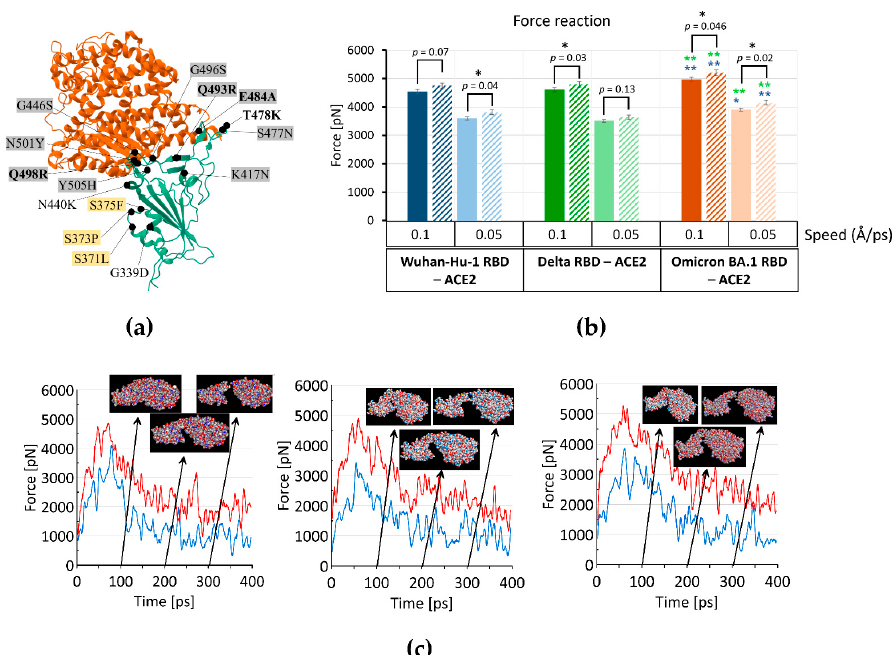
Figure 1. ( a ) Cryo-EM structure of SARS-CoV-2 Spike Omicron BA.1 RBD (cyan) with ACE2 domain (orange) (https://www.rcsb.org/3d-view/7T9L/1, assessed on 1 June 2022). Positions mutated in Omicron BA.1 are shown as black circles. Grey boxes indicate mutations that are at the binding interface with ACE2, N440K, and T478K are just peripheral and might influence the binding, and yellow boxes indicate mutations that affect the lipid-binding pocket of Spike RBD [45,64,67,68]. Bold—mutations within RBM at the binding interphase with ACE2 or adjacent to it that increase the positive charge (T478K, Q493R, Q498R) or decrease the negative charge (E484A) according to [56,57]. ( b ) The force reaction in steered Molecular Dynamics simulations of separating the RBD domain from the ACE2 with constant speed 0.1 or 0.05 Å/ps (indicated below the x-bar) of different SARS-CoV-2 variants: Wuhan-Hu-1 (6m0j, dark and light blue), Omicron BA.1 (7t9l, dark and light red), Delta (7w9i, dark and light green), and each protonated form (diagonal line pattern). The mean of eight independent experiments is shown in each case, and the standard error of the mean is shown as error bars. The t -test was used for comparing the means, and p -levels are indicated above the bars; *—denotes a significant difference at the p -level < 0.05, **—denotes significant difference at the p -level < 0.01. Blue and green asterisks above the Omicron BA.1 bars correspond to significant differences between the corresponding bars of Omicron BA.1 RBD and Wuhan-Hu-1 RBD (blue) and Omicron BA.1 RBD and Delta RBD (green). ( c ) Timeline (Force pN/Time ps) of pulling the RBD of Wuhan-Hu-1, Omicron BA.1, and Delta with constant speed 0.1 Å/ps from the ACE2 domains, all unprotonated variants. Force reaction of ACE2 (blue) and Spike RBD (red) domains. Three- dimensional-structures at the top of the figure correspond to 100, 200, and 300 ps of trajectory. At the end of the pulling, last destructed contacts were for 6m0j: S19 and T27 from ACE2 and S477 and F486 from RBD; for 7t9l: E23 and T20 from ACE2 and N477 and F486 from RBD; for 7w9i: S19 and T27 from ACE2 and S477 and F486 from